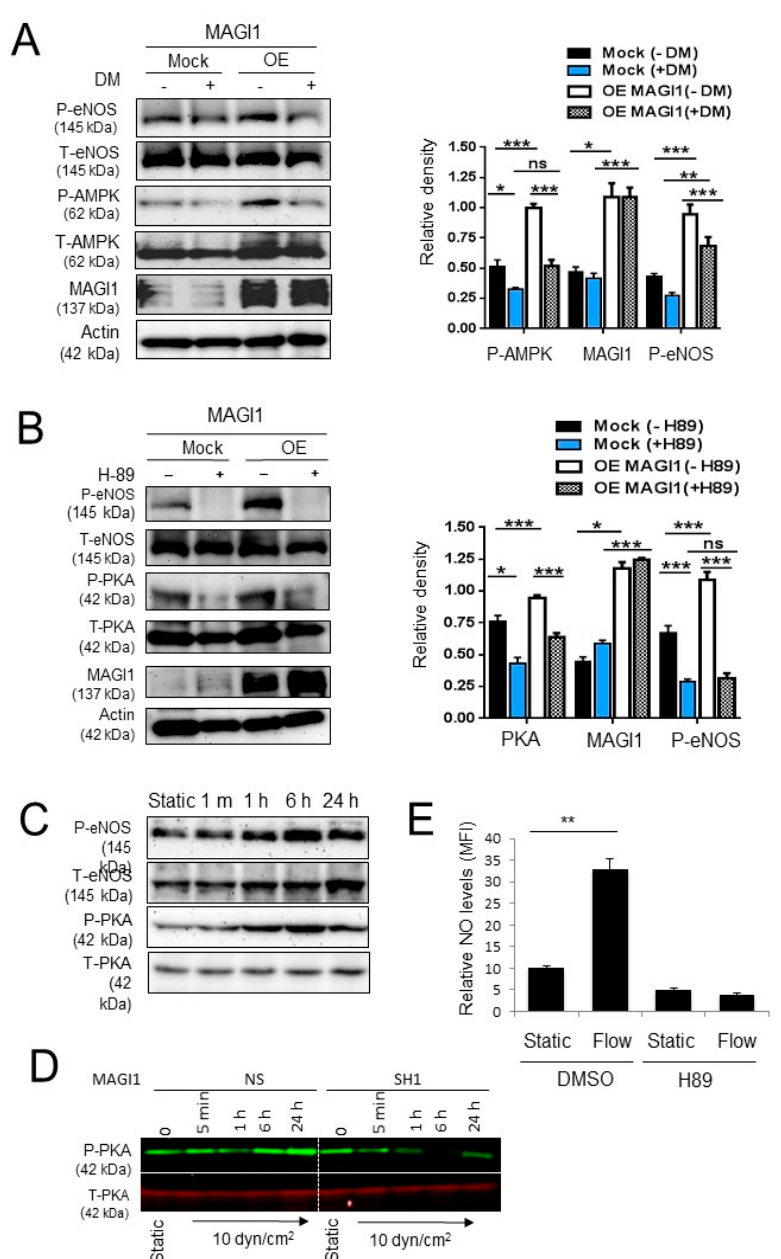
Figure 4. AMPK and PKA mediate MAGI1-induced eNOS phosphorylation. ( A ) Control (Mock) and MAGI1-overexpressing (OE) HUVEC treated with the AMPK inhibitor dorsomorphin (DM, + ) or DMSO vehicle control ( − ), were analysed by Western blotting for phosphorylated AMPK (Thr 286 ), total AMPK, phosphorylated eNOS (Ser1177) and total eNOS. N = 3. AMPK mediate MAGI1-induced eNOS phosphorylation. ( B ) Western blotting analysis of phosphorylated PKA (Thr 197 ), total PKA, phosphorylated eNOS and total eNOS in control (Mock) and MAGI1 overexpressing (OE) HUVEC in the presence of absence of the PKA inhibitor H-89. PKA mediates MAGI1-induced eNOS phosphorylation. N = 3. Beta actin is shown as loading control. Relative band quantifications by densitometry of multiple experiments is shown next to the blots. * p < 0.05; ** p < 0.01; *** p < 0.001; ns, non-significant. ( C ) HUVEC cultured under static conditions (0) or exposed to 10 dyn / cm 2 fluid shear stress in the orbital shaker (OS) systems for the indicated time were analysed for phosphorylated eNOS (Ser1177), total eNOS, phosphorylated PKA (Thr 197 ) and total PKA levels by Western blotting. ( D ) HUVEC non-silenced (NS) or silenced (SH4) for MAGI1 were cultured under static conditions or exposed to 10 dyn/cm 2 fluid shear stress in the orbital shaker (OS) systems for the indicated time and